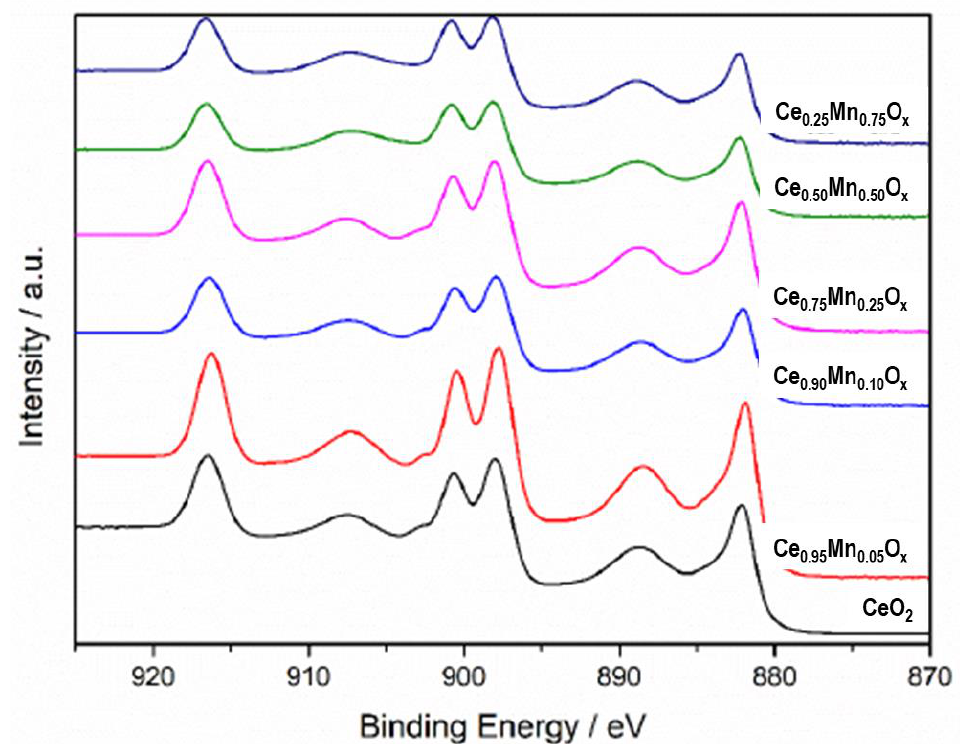
Figure 5. Ce 3d XPS spectra for the ceria-manganese samples prepared by sodium carbonate co-precipitation.